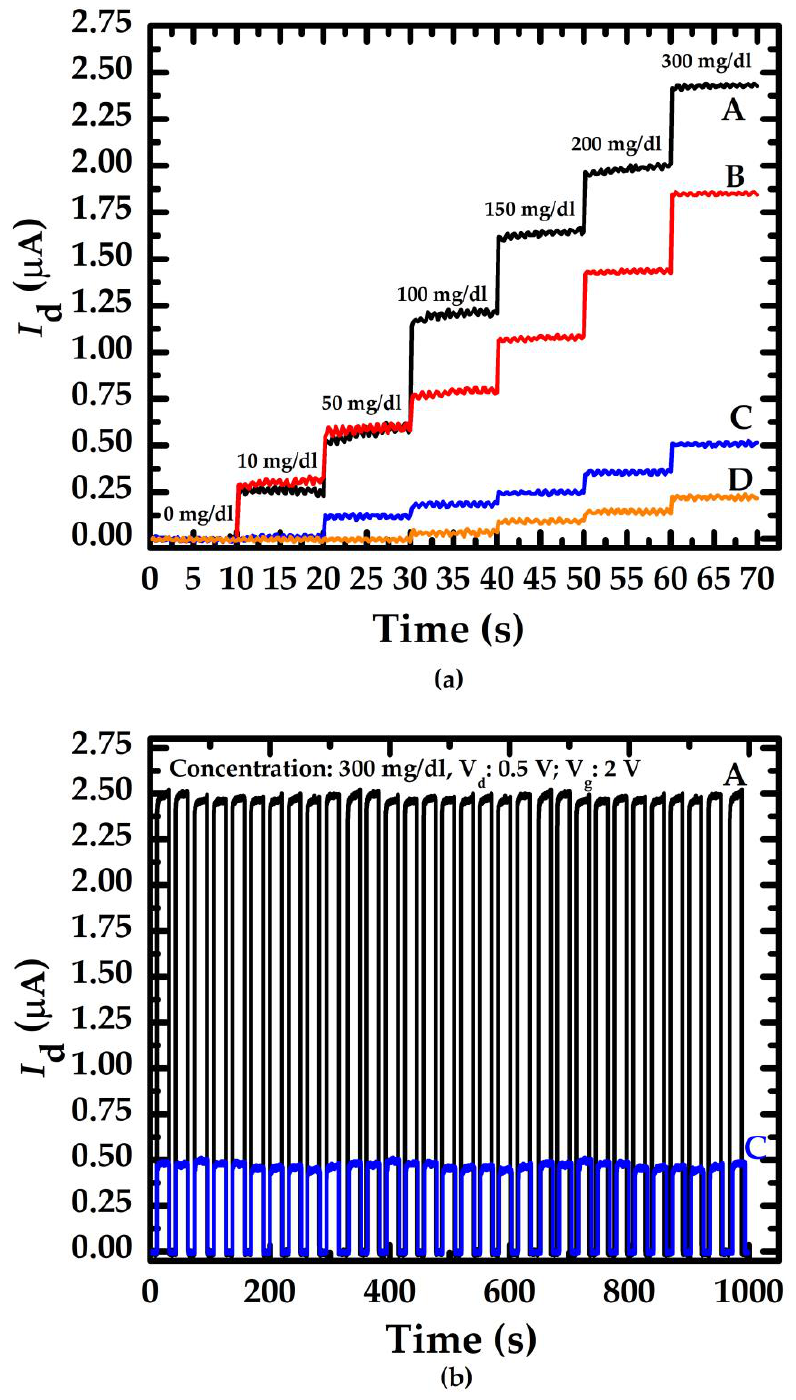
Figure 6. Current-time response curve of doped/undoped poly-Silicon nanowire with various nanowire length. ( a ) Relationship between the drain current and concentration of glucose; ( b ) Repeatability of the doped/undoped nanowire sensor with length of 3.5 μ m.